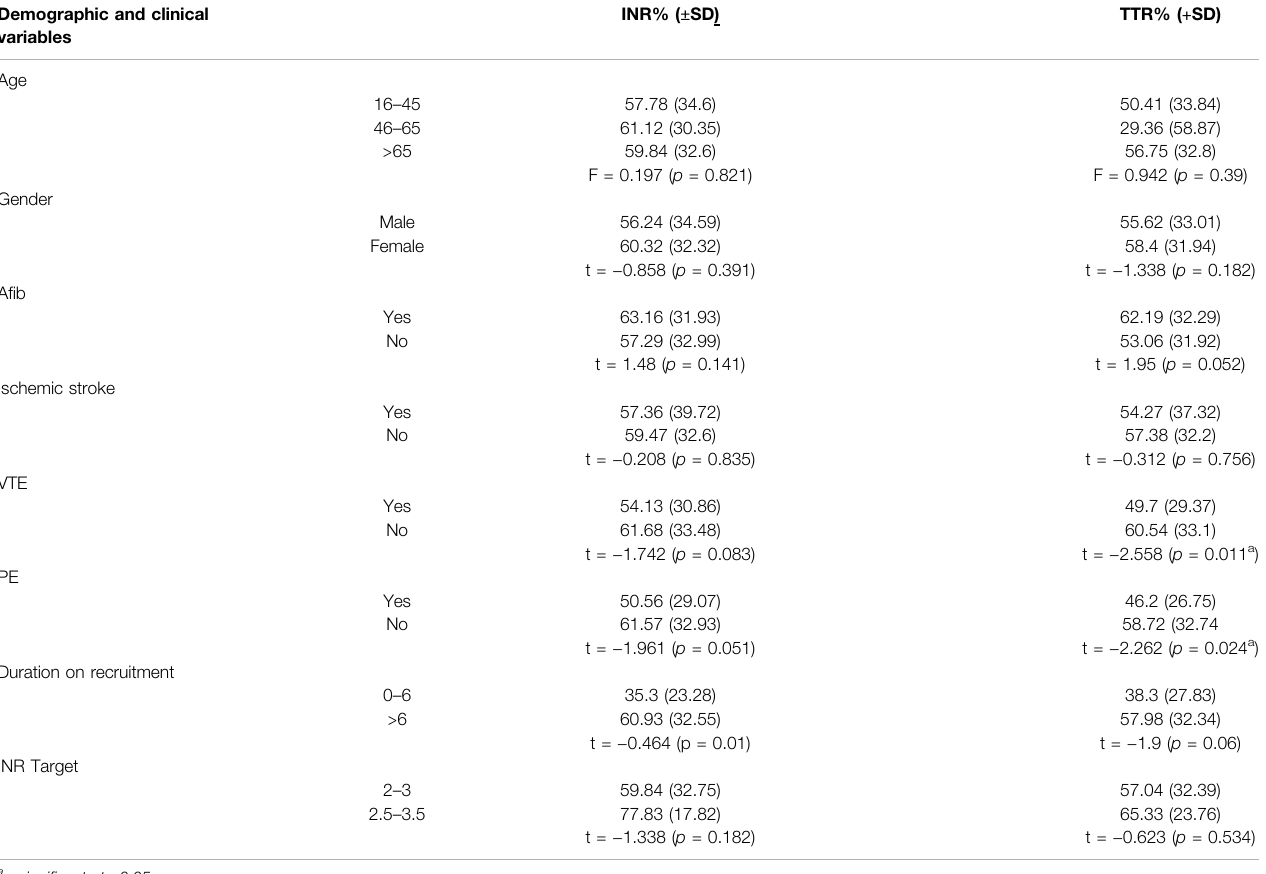
TABLE 5 | Signi fi cance of mean INR and TTR with respect to variables. Demographic and clinical variables